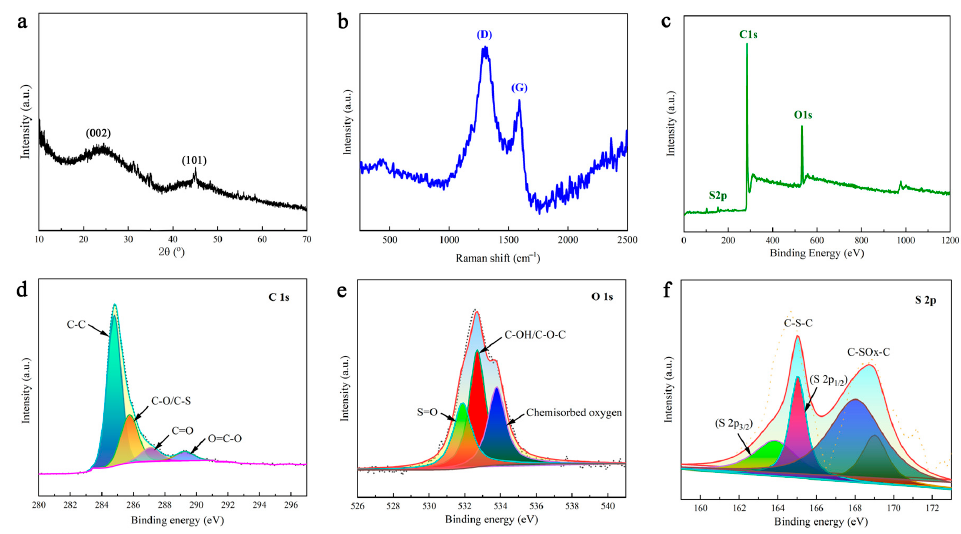
Figure 3. ( a ) XRD patterns, ( b ) raman spectra and ( c ) high resolution XPS spectra of full spectrum ( d ) C 1s, ( e ) O 1s and ( f ) S 2p from DMAL.